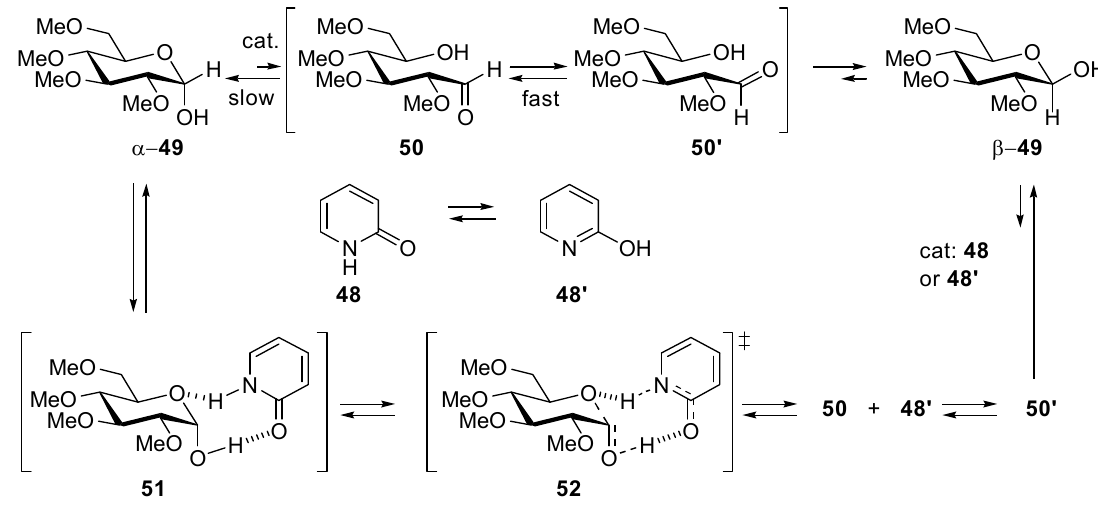
Scheme 27. Mutarotation of tetramethylglucose catalyzed by the bifunctional catalyst α‐ pyridone ⇄